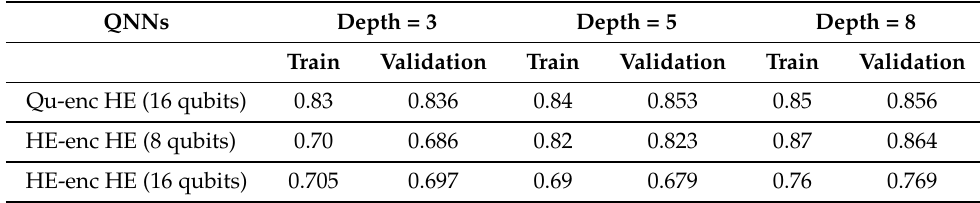
Table 1. Training and validation accuracy of qubit-encoded and HE-encoded QNNs.